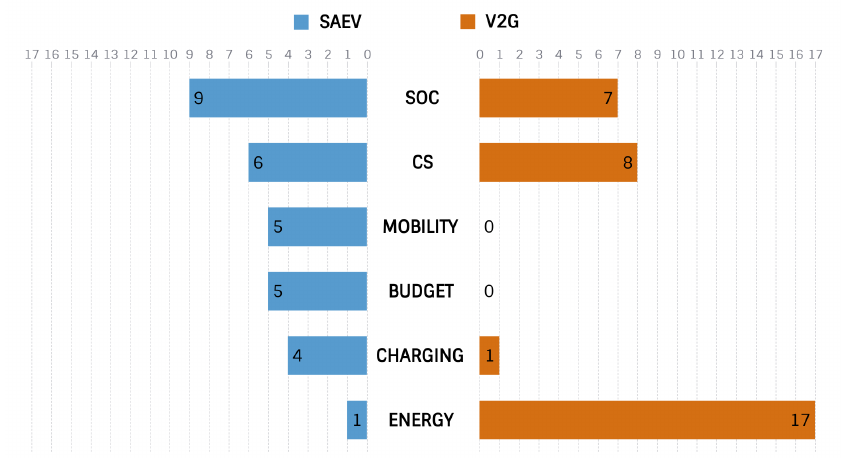
Figure 8. Constraints considered in the reviewed